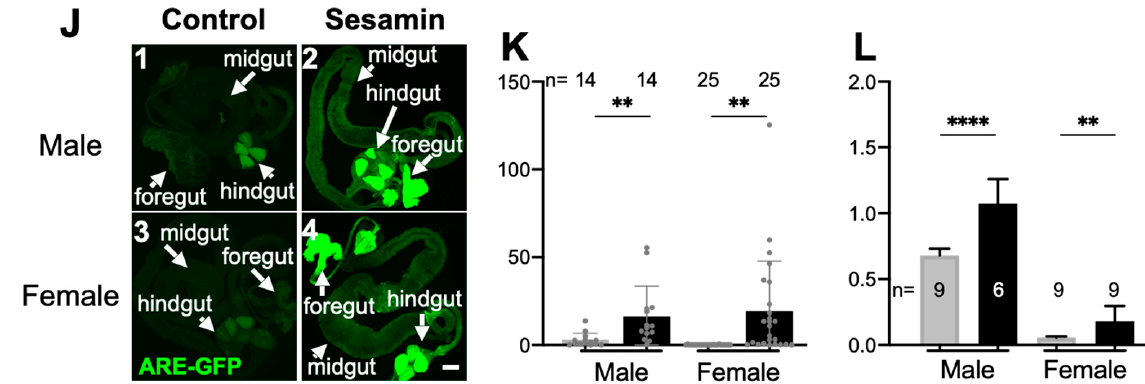
Figure 1. GFP fluorescence of antioxidant response element (ARE)-GFP reporter in whole bodies, brains and gut in adults fed sesamin. ( A ) Stereo micrographs of male and female flies with ARE-GFP reporter (ARE) fed on a fly diet supplemented with 10 mM paraquat (paraquat) for 7 days. ( A1 – A4 ) Bright field microscopy of a male ( A1 ) and a female ( A3 ) without paraquat feeding, and a male ( A2 ) and a female ( A4 ) with the paraquat administration. ( A5 – A8 ) GFP fluorescence after irradiation of excitation light for GFP. ( B ) Quantification of GFP positive area in whole bodies of males or females fed on the diet with or without paraquat. The area was calculated by Image J for each treatment ( n = 10). ( C ) Quantification of GFP mRNA levels in males or females fed on the diet with or without paraquat. Paraquat feeding stimulates a transcription of ARE-GFP reporter. ( D ) Stereo fluorescence micrographs of male and female flies with ARE, fed with 2 mg/mL sesamin or without the chemical for 7 days. ( D1 – D4 ) bright field microscopy of a male ( D1 ), and female ( D3 ) without drug administration, and those of a male ( D2 ) and a female ( D4 ) with the sesamin administration. ( D5 – D8 ) GFP fluorescence after irradiation of excitation light for GFP. ( E ) Quantification of GFP positive area in the whole bodies of males or females fed on the diet with or without sesamin. The area was calculated by Image J for each treatment ( n ≥ 10). ( F ) Quantification of GFP mRNA levels in the whole bodies of males or females fed on the diet with or without sesamin. The relative GFP mRNA level was quantitated by qRT-PCR performed using total RNA extracted from 10–15 whole bodies. The sesamin feeding 2 mg/mL stimulates transcription of ARE-GFP reporter in the whole adult bodies. ( G , J ) GFP fluorescence of confocal micrographs in adult whole brains ( G ), and adult gut ( J ). ( G1 – G4 ) GFP fluorescence of a male brain ( G1 ), and female brain ( G3 ) from adults raised without the chemical, and those of a male brain ( G2 ) and a female brain ( G4 ) from adults with the sesamin administration. ( H ) Quantification of GFP positive area in whole brains of males or females fed with or without sesamin. ( I ) The relative mRNA level of GFP was quantitated by qRT-PCR using total RNA from 40–50 heads. ( J ) Foregut, midgut, and hindgut are indicated individually by arrows. ( J1 – J4 ) GFP fluorescence of a male gut ( J1 ), and female gut ( J3 ) from adults raised without the chemical, and that of a male ( J2 ), and female gut ( J4 ) from adults with the sesamin administration. ( K ) Quantification of GFP positive area in gut of males or females fed with or without sesamin. ( L ) Quantification of GFP mRNA level in adult guts of males or females fed with or without sesamin. The relative mRNA level of GFP was quantitated by qRT-PCR using total RNA from 30–40 abdomens. The sesamin feeding stimulated ARE-dependent transcription in the adult brains and gut in both sexes. Scale bars in ( G , J ) represent 100 µ m. * p < 0.05, ** p < 0.01, **** p < 0.0001 (Student’s t